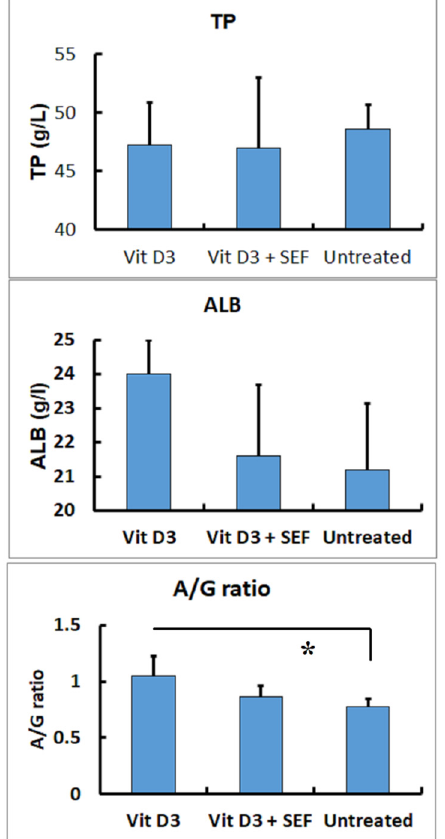
Figure 1. Serum biochemical findings in TP and ALB concentrations and A/G ratios. No significant differences are seen in TP and ALB concentrations among the 3 groups. The Vit D 3 -treated group shows a decrease in A/G ratios. *: Significantly different between the Vit D3-treated and the untreated groups ( p < 0.05).